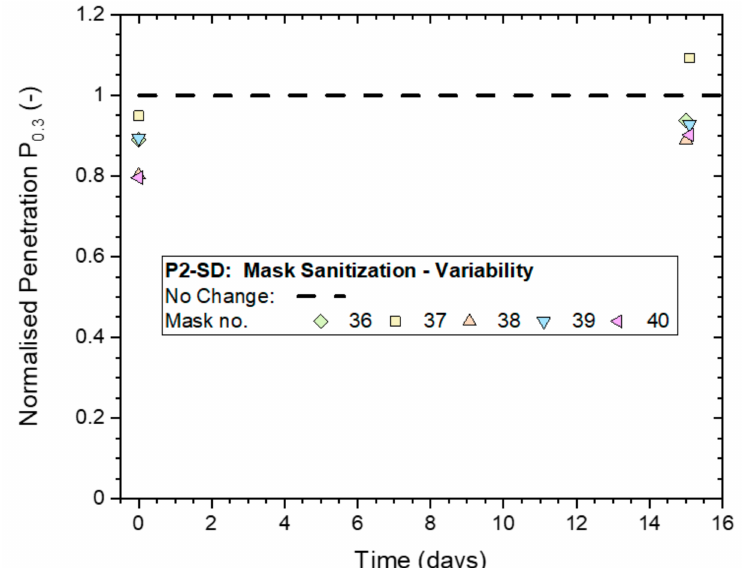
Figure 14. Variation in the Normalized penetration P n0.3 from whole-mask screening tests between five masks (P2-SD: Shanghai Da Sheng) after exposure to mask sanitization application of 70% IPA solution and subsequent storage in plastic bags for up to two